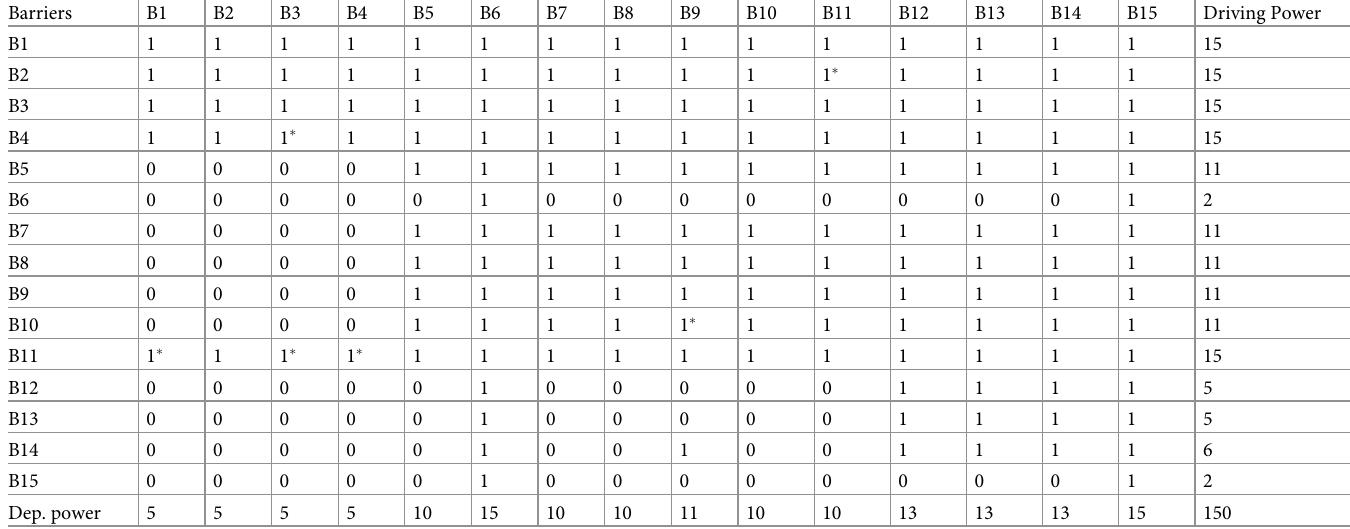
Table 8. Final reachability matrix.